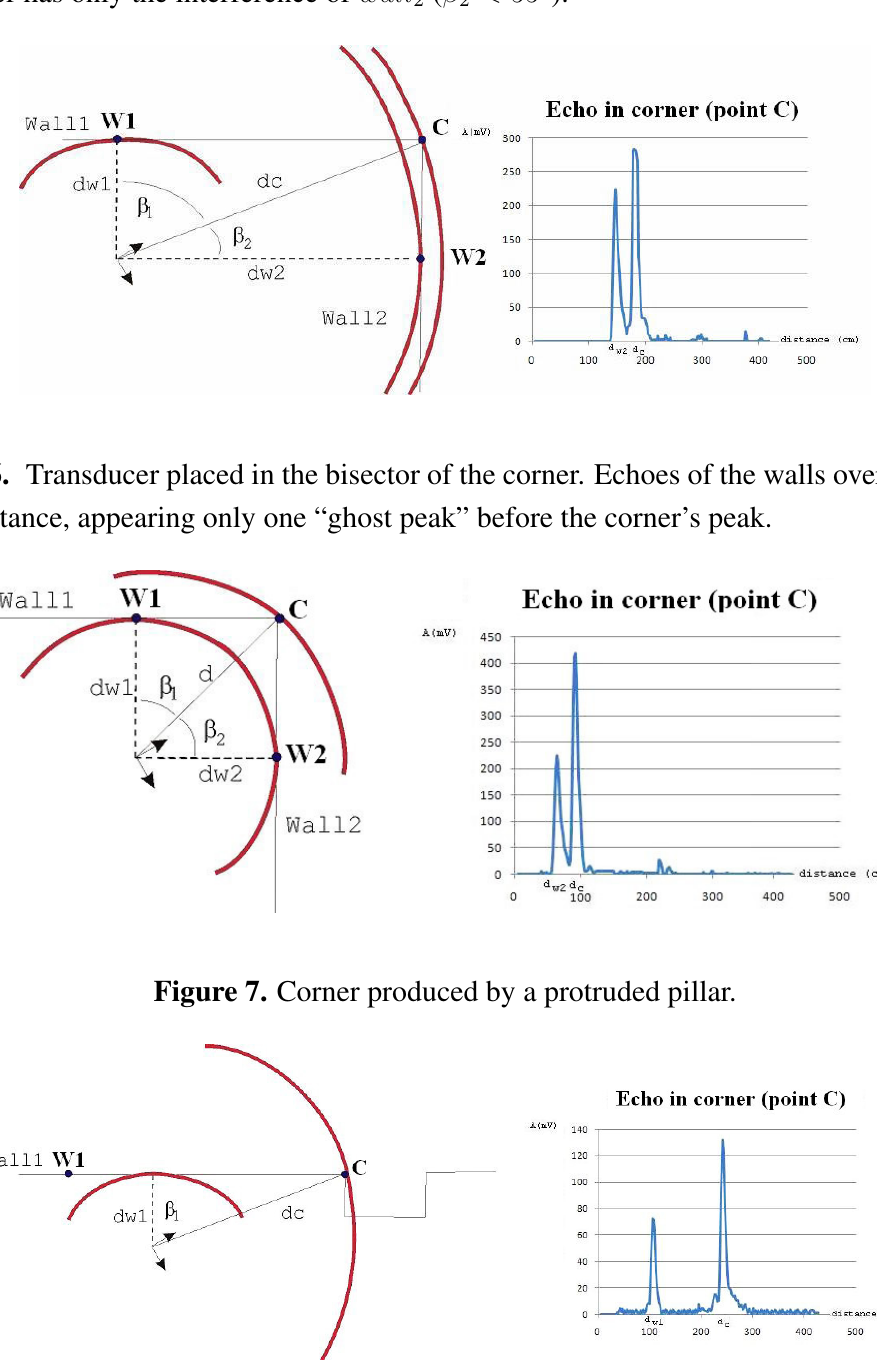
Figure 5. Single “ghost peak”. Case of far corner. Angle β the corner has only the interference of wall